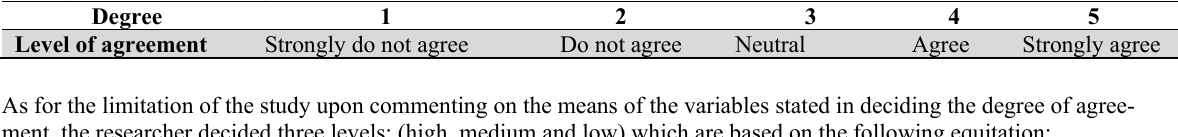
Testing the measure of the questionnaire Degree 1 Level of agreement Strongly do not agree